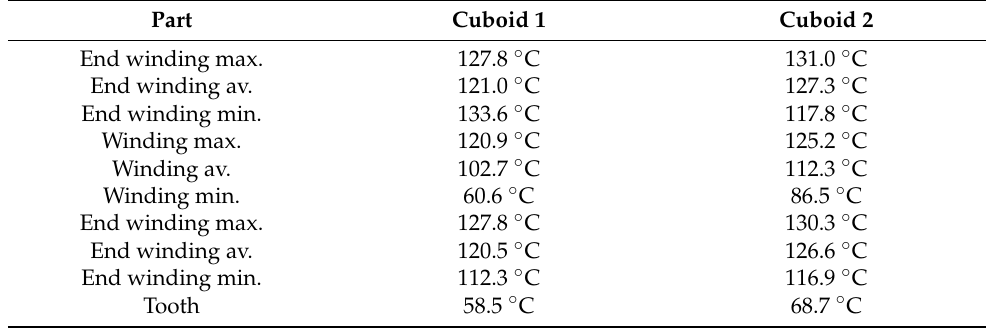
Table 17. Winding temperature graph for water-cooled motor with PA6GF30